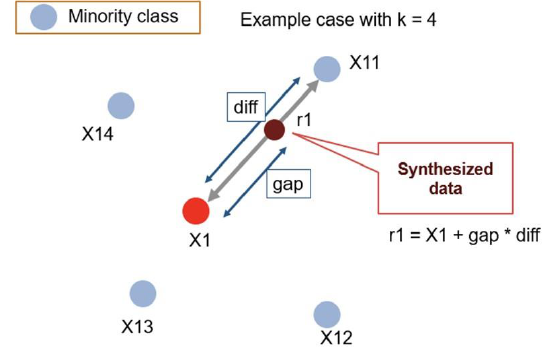
Figure 2. Working procedure of SMOTE. Source: https://github.com/minoue-xx/Oversampling- Imbalanced-Data (accessed on 20 February 2023).